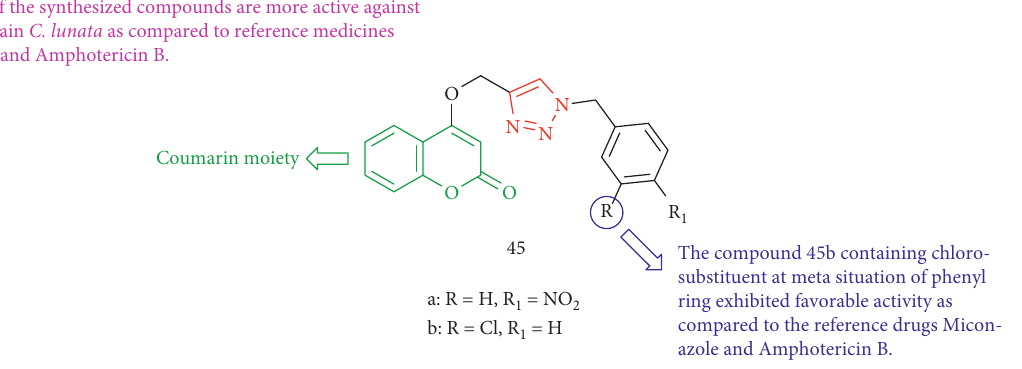
Figure 6: Chemical structure of novel coumarin incorporated triazoles.